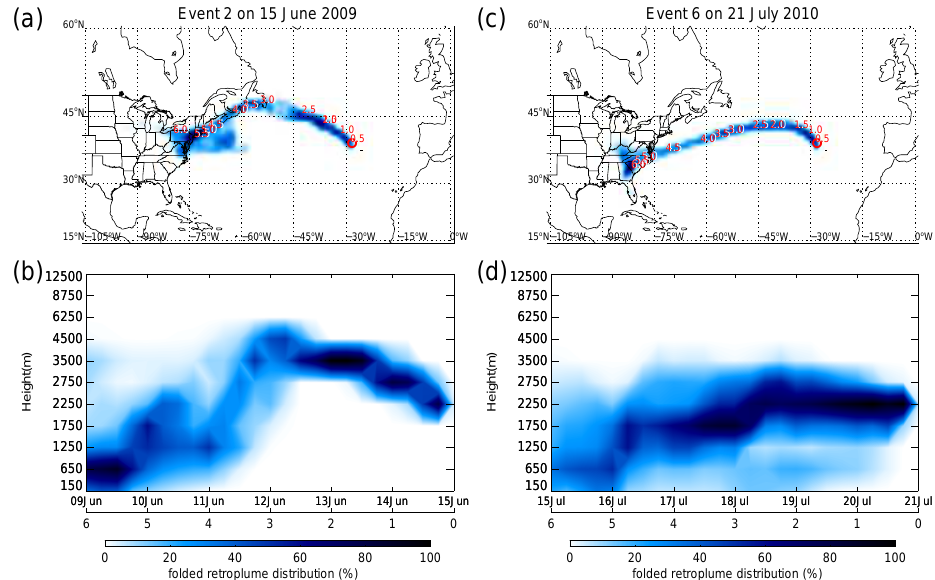
Fig. 3. FLEXPART folded retroplumes of events 2 and 6 discussed in text: (a) and (c) are plan views of FLEXPART folded retroplumes with locations at each upwind time labeled by red numbers in days; panels (b) and (d) are vertical distributions of FLEXPART folded retroplumes with dual x-axis labels, showing both date (in UTC) and upwind time. Folded retroplume concentration is shown using a scale normalized to the highest concentration at each upwind time to provide a clearer view of transport